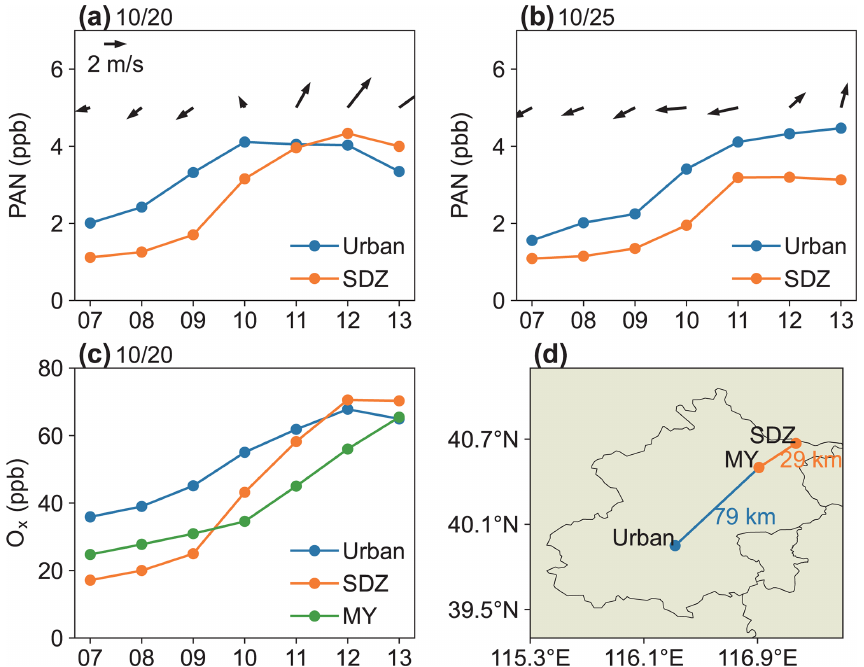
Figure 5. Hourly variations in PAN concentrations (ppb) and surface wind at the urban and SDZ site during 07:00–13:00LT on (a) 20 October and (b) 25 October. (c) Hourly variations in O x concentrations (ppb) at the urban, SDZ, and MY site during 07:00–13:00LT on 20 October. (d) Detailed locations of the urban, SDZ, and MY site and the distances between them.